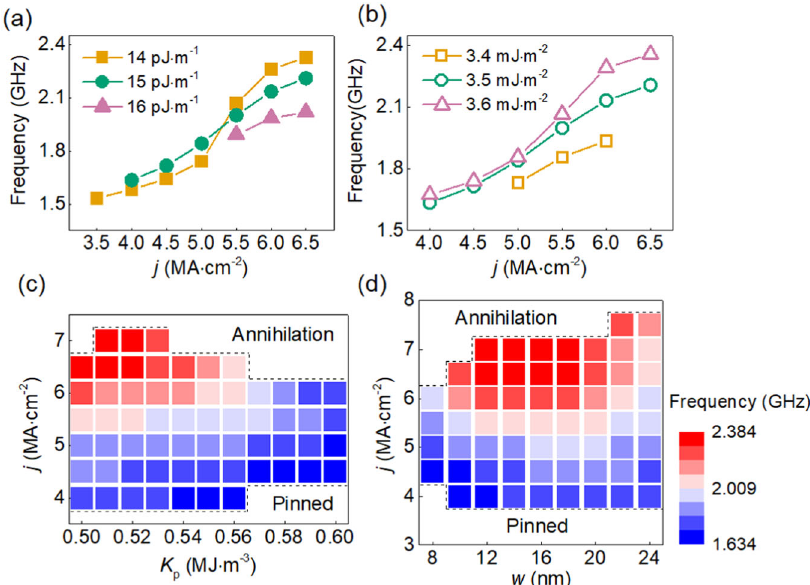
Fig. 5 Parametric dependence of oscillation frequency. The oscillation frequency as a function of the driving current density j for different exchange stiffness A and Dzyaloshinskii-Moriya interaction constant D . Here, D is fi xed at 3.5 mJ m − 2 in ( a ), and A = 15 pJ m − 1 in ( b ). The yellow fi lled squares, green fi lled circles and pink fi lled triangles in ( a ) denote the case of A = 14, 15 and 16 pJ m − 1 , respectively. The yellow squares, green circles and pink triangles in ( b ) represent the case of D = 3.4, 3.5 and 3.6 mJ m − 2 , respectively. Phase diagrams of the oscillation versus the current density j and ( c ) the perpendicular magnetic anisotropy value K p or ( d ) the width w of the pinning sites, where A = 15 pJ m − 1 , D = 3.5 mJ m − 2 and the color bar represents the oscillation frequency.